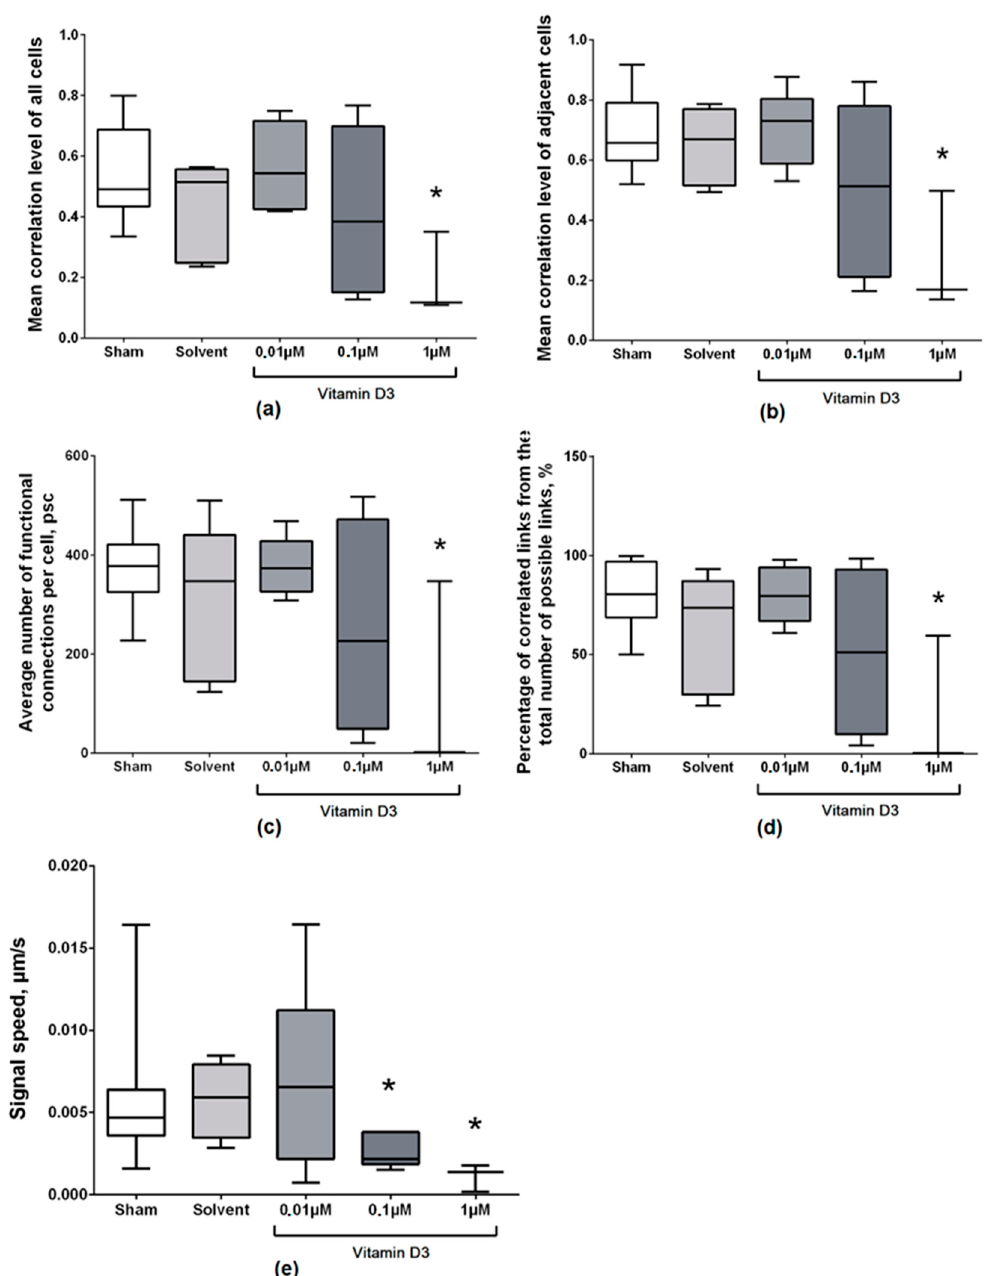
Figure 2. Main parameters of the network activity of primary neuronal cultures on day 7 after vitamin D3 application. ( a ) Mean correlation level of all cells in the culture; ( b ) Mean correlation level of adjacent cells; ( c ) Average number of functional connections per cell; ( d ) Percentage of correlated connections from the total number of possible connections; ( e ) Signal delay rate between cells. * versus “Sham”, p < 0.05, the Mann–Whitney test.